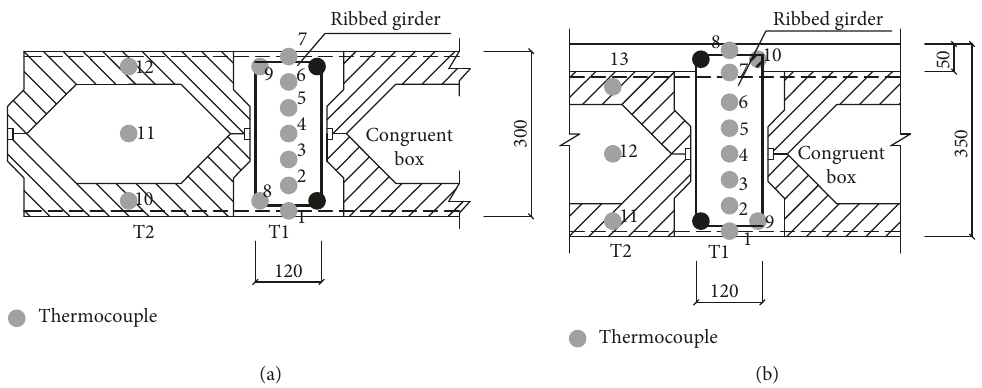
Figure 8: Arrangement of thermocouples. (a) Open box. (b) Covered